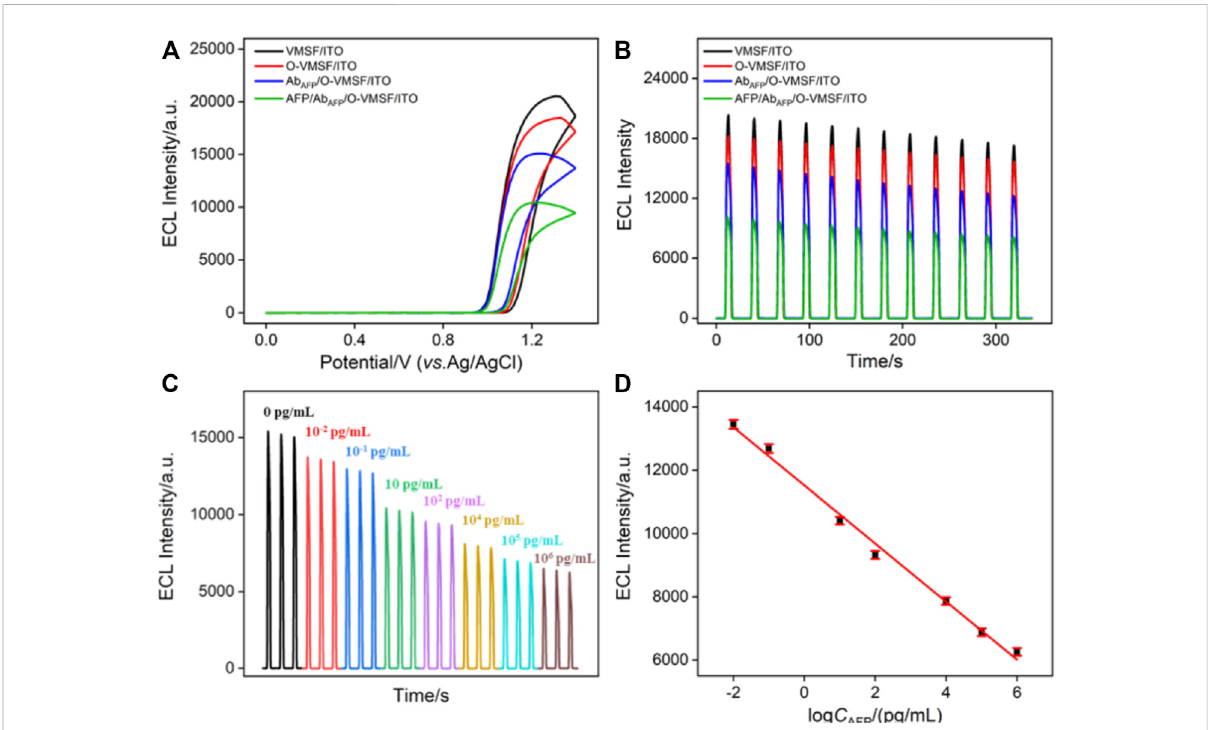
ECL – potential (A) and ECL – time (B) curves obtained at different electrodes. The concentration of AFP is 1 pg/ml. (C) ECL responses of the ECL immunosensor in the presence of different concentrations of AFP. (D) Corresponding calibration curve. Error bars represent the standard deviation of three measurements. The electrolyte is 0.01 M PBS (pH = 7.4) containing 10 μ M Ru (phen) 3 2+ and 3 mM TPA. The PMT voltage is 500